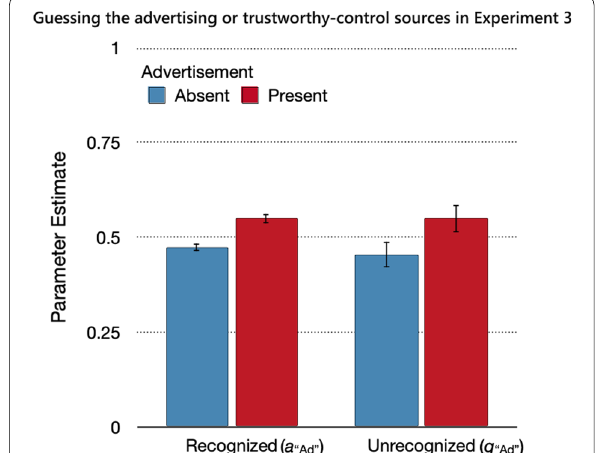
Fig. 9 Guessing the advertising or trustworthy-control sources in Experiment 3. Note : Parameter estimates of the parameters reflecting the probabilities of guessing that recognized and unrecognized